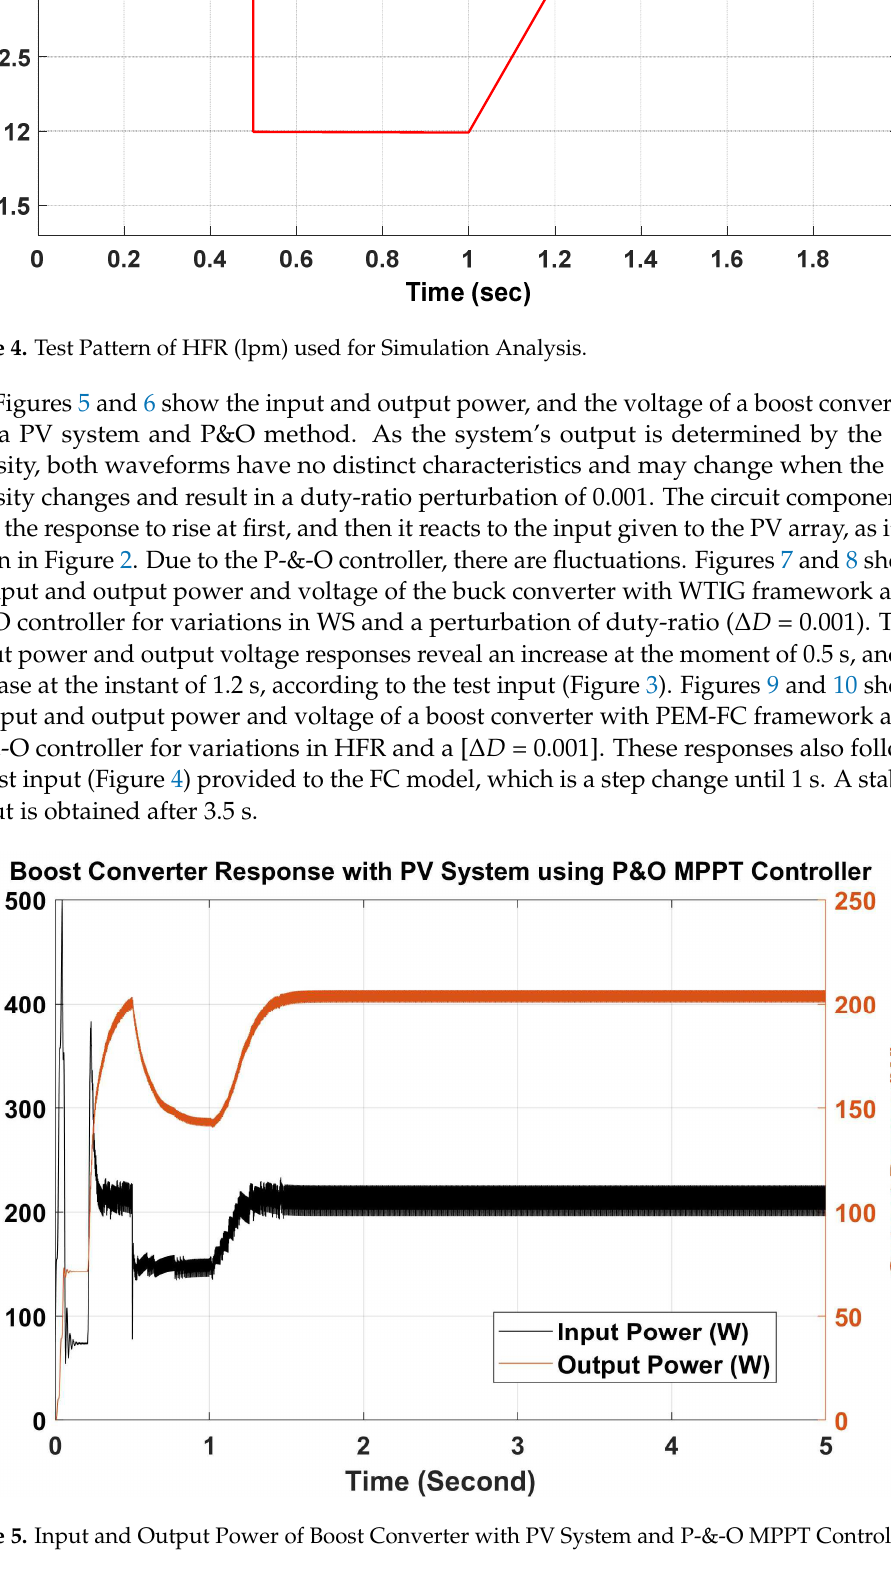
Figure 6. Input and Output Voltage of Boost Converter with PV System and P-&-O MPPT Control- ler.